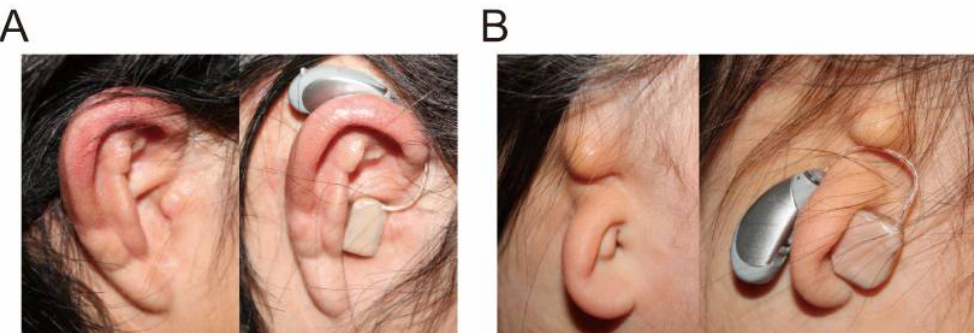
Figure 5. Examples of ears with and without cartilage conduction hearing aid (CC-HA). Some patients wear CC-HA in the same manner as conventional behind-the-ear hearing aids ( A ). For other patients, double-sided tape is needed for fixation of the hearing aids ( B ). (Figure 5 was originally presented in Nishimura et al. 2018, Figure 1 [40]).